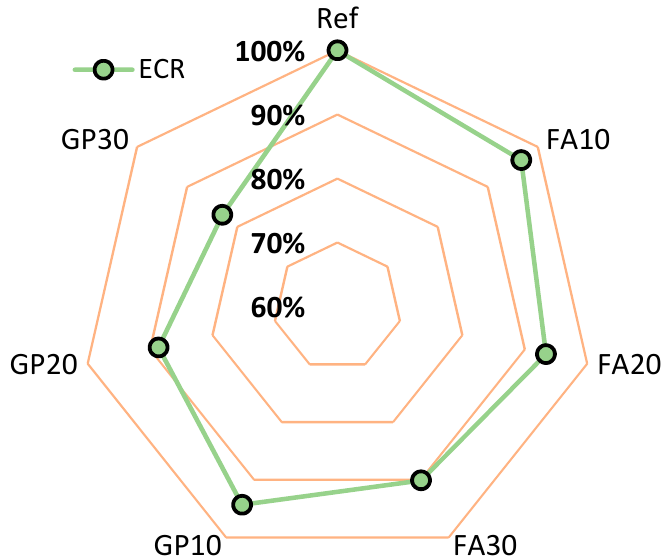
Figure 17. Effective cost ratio ( ECR ) value with regards to the type of cementitious mortar series.